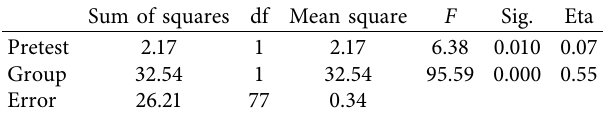
Table 3: Univariate analysis of covariance (ANCOVA) results.